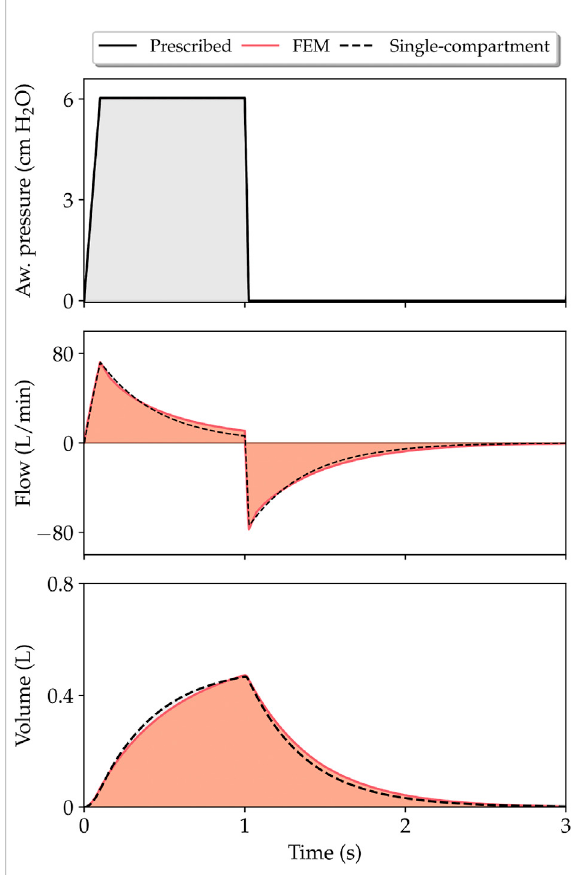
FIGURE 4 Comparison of respiratory variable evolution as predicted by fi nite-element simulations (CM3 model) and single-compartment